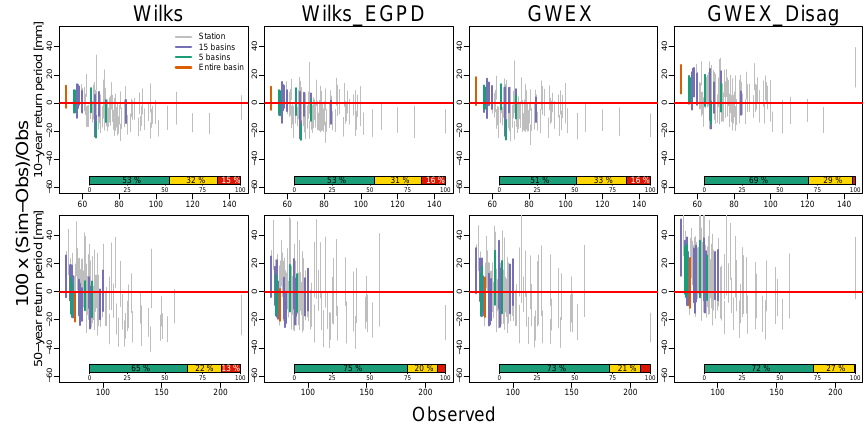
Figure 12. Daily annual maxima for all spatial scales: relative differences, expressed as a percentage, between observed and simulated 10- year (top plots) and 50-year (bottom plots) return periods. The 90% probability limits are shown. Overall performance is represented by the indicated percentages of good, fair, and poor performance for all spatial scales.